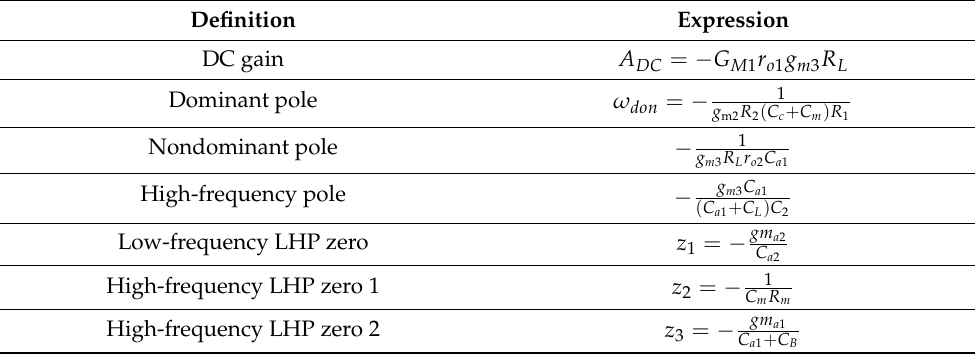
Figure 6. The equivalent small-signal model of the AFFC cascode compensation. Table 1. The frequency property summarization of the proposed